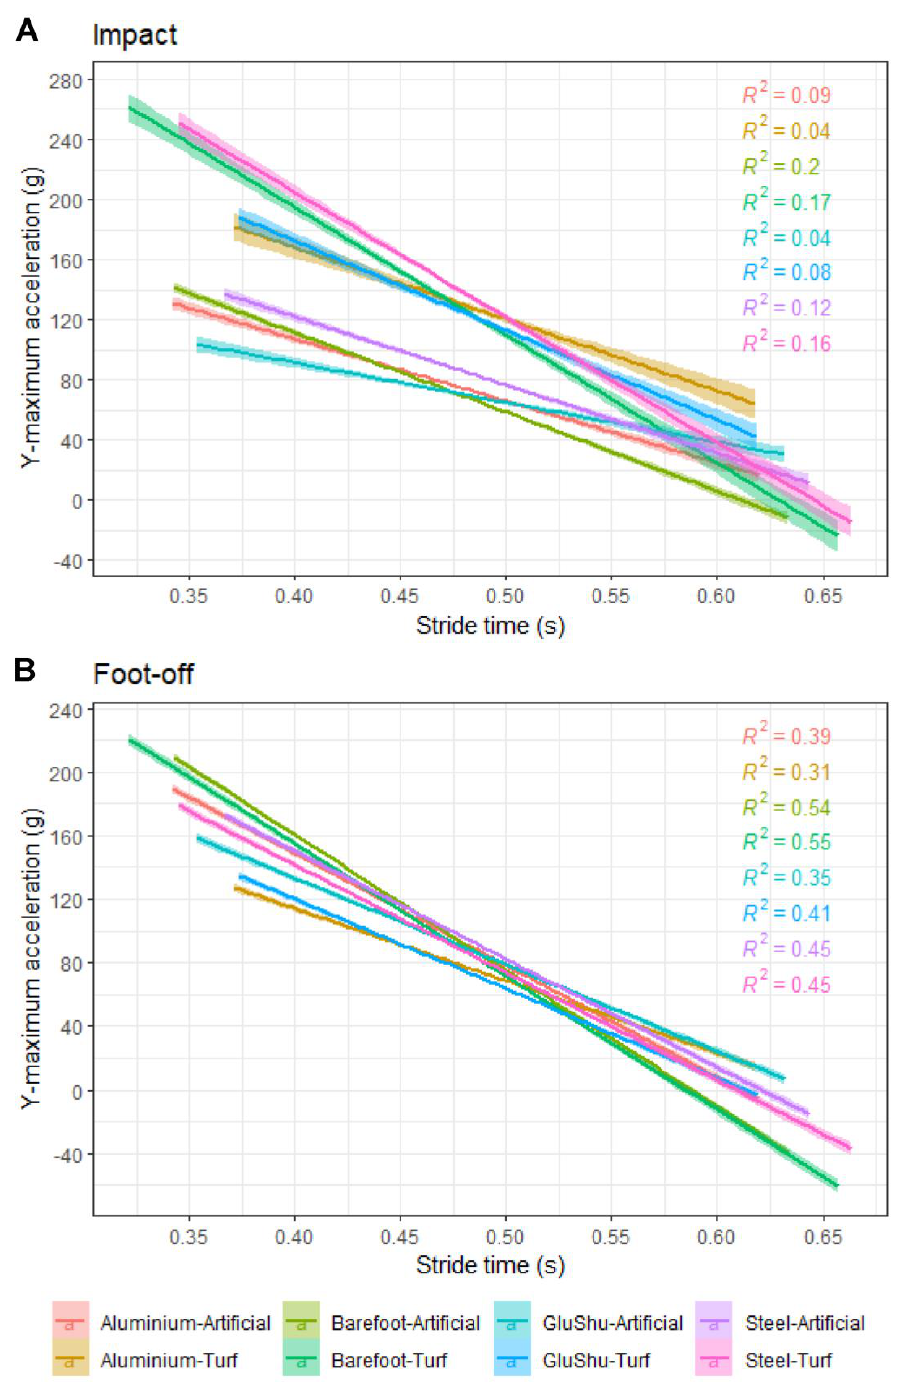
Figure 4. Relationship between hoof accelerations and stride time for the y-maximum parameter at ( A ) impact and ( B ) foot-off, subdivided by the shoe – surface combination for the entire dataset. The r 2 values for the linear regressions are indicated. All p < 0.001.